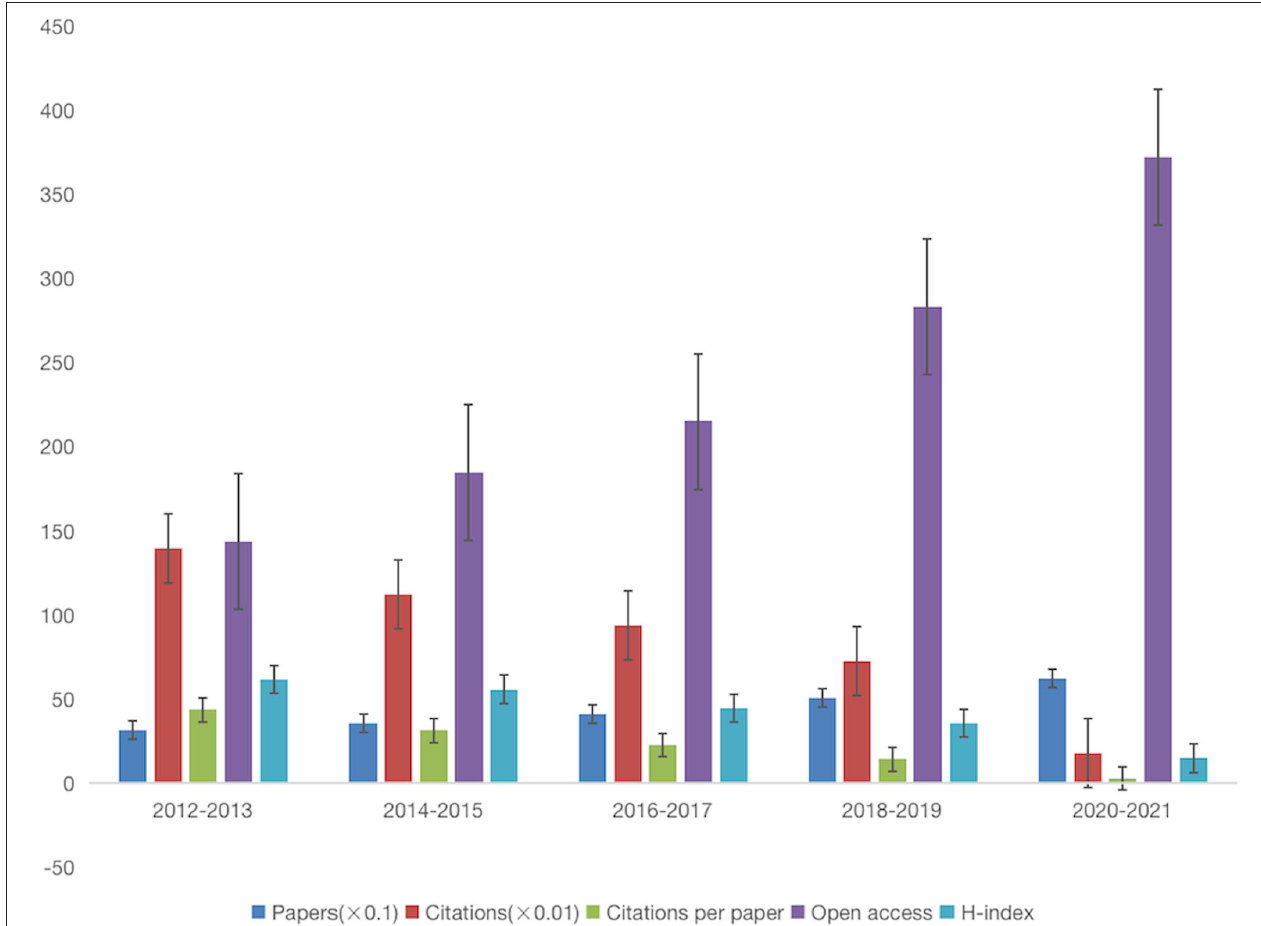
FIGURE 2 | Number of papers, citations, citations per paper, open access, and H-index per 2-year time period for the exercise research on PD.